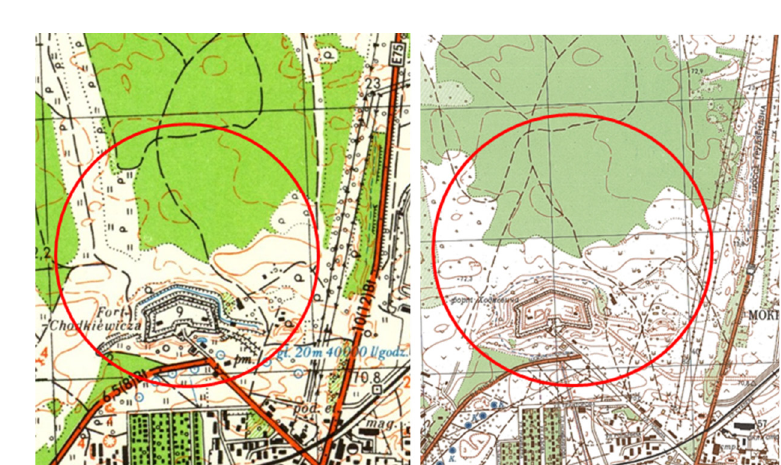
Fig. 3. The Soviet base in Toruń shown on the Polish map 1:25,000 (part of sheet N-34-98-C-c Toruń, General Staff of the Polish Army, 1956, second edition) and on an American satellite image from July 28, 1969